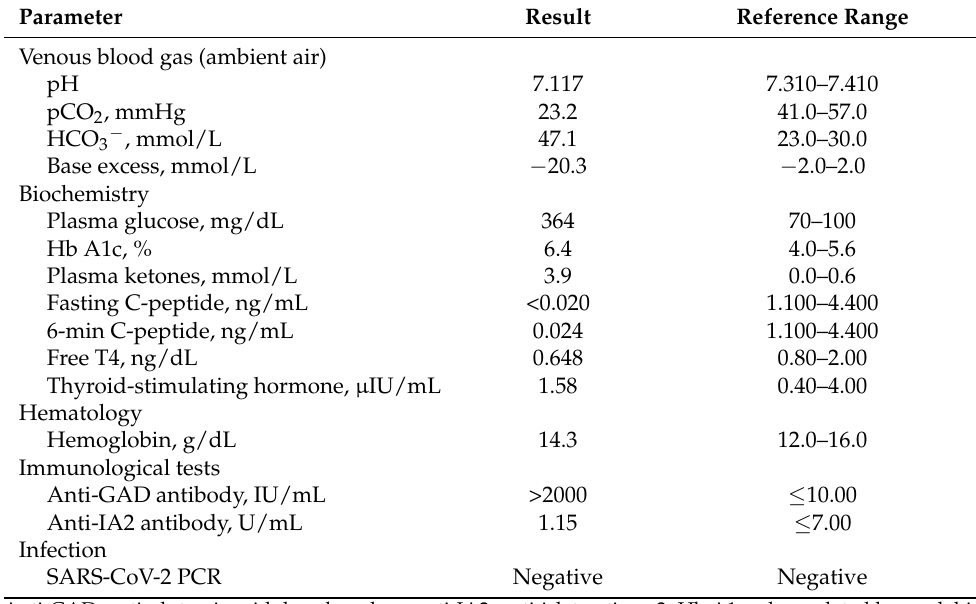
Table 1. Laboratory